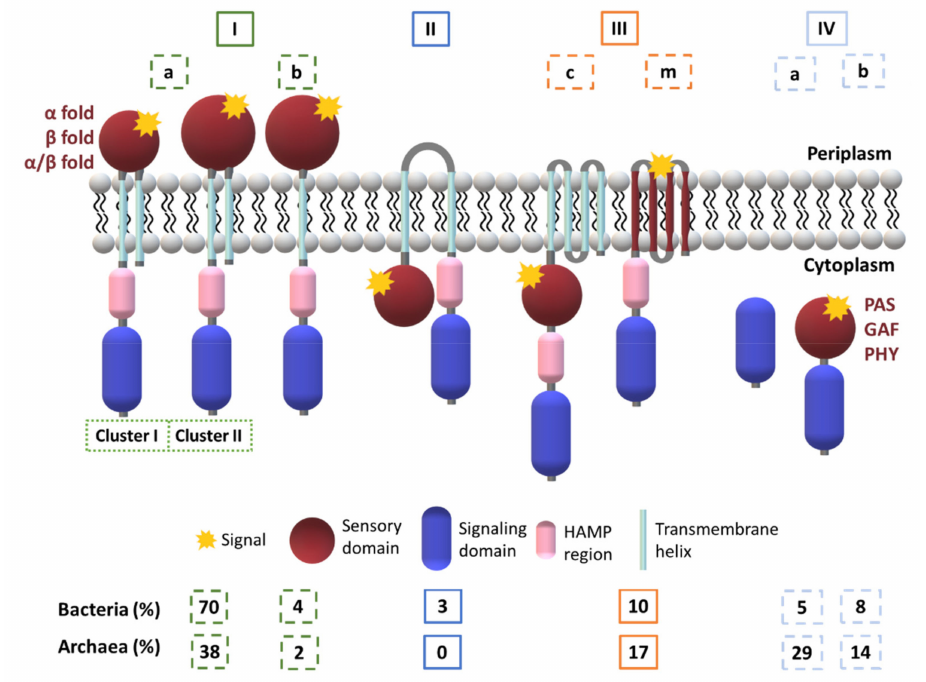
Figure 9. Classification of MCP according to Lacal and co-workers